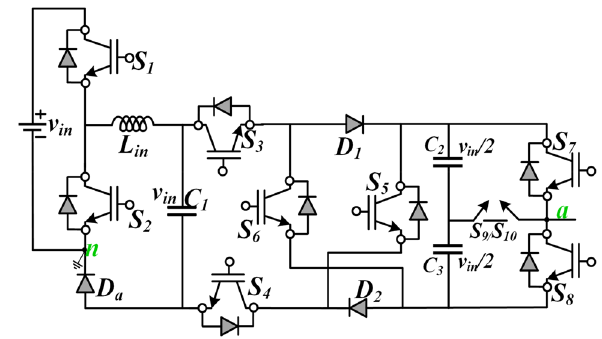
Figure 1. Proposed CGT-CSC 9L circuit